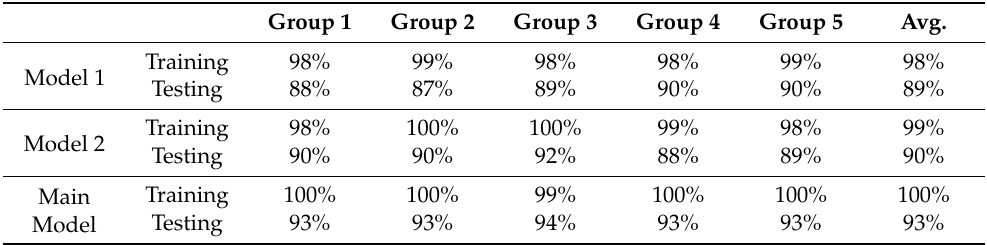
Table 4. Accuracy rate of Models after image augmentation.